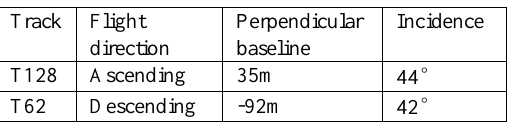
(Jónsson et al., 2002) to down-sample data points, and 1630 and 459 points were left for ascending and descending